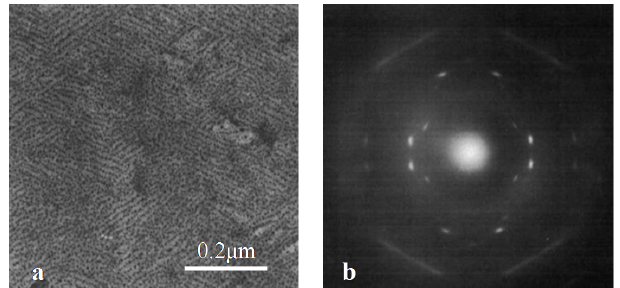
Figure 16. A phase contrast bright field electron micrograph ( a ) and its corresponding electron diffraction pattern ( b ) of iPBu melt-crystallized on potassium salts. Reproduced with permission from Ref. [118], copyright 1994 Butterworth-Heinemann Ltd.